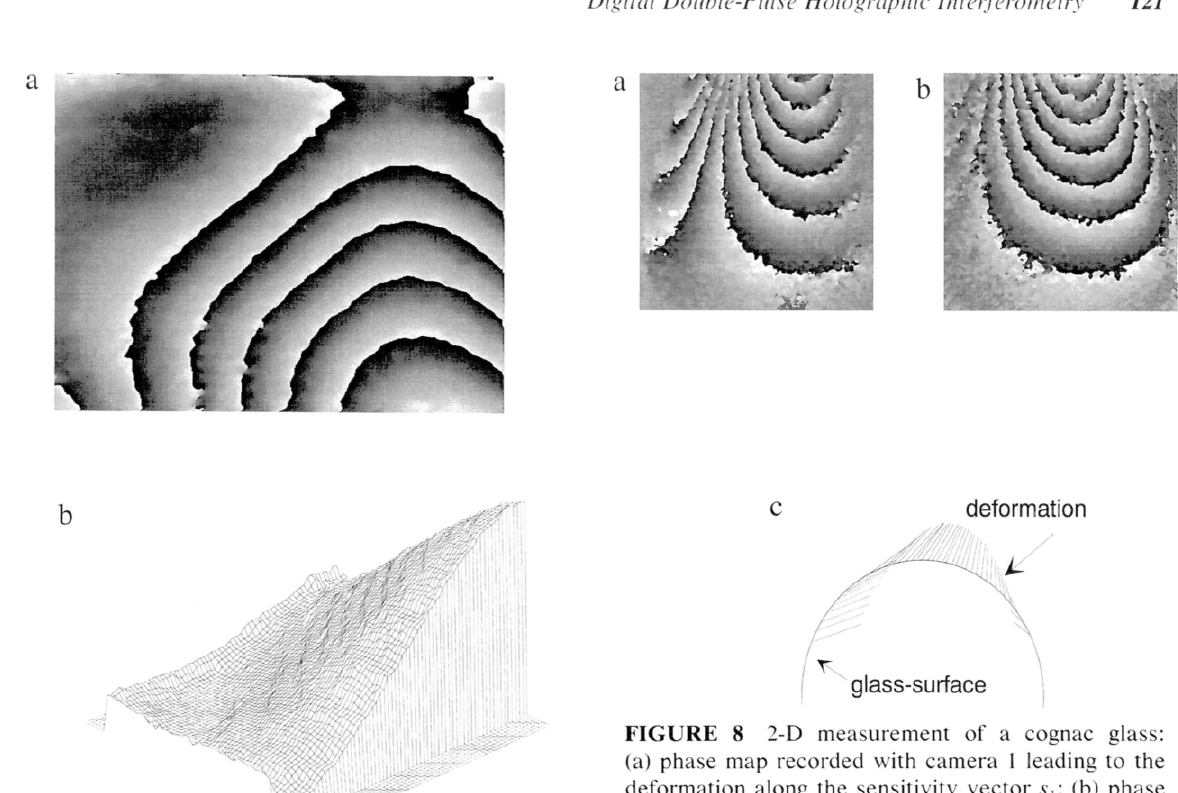
FIGURE 6 Deformation of a plate between 150 and 250 fLs after the impact of a pendulum on the plate: (a) phase map and (b) pseudo-3-D representation of the deformation.